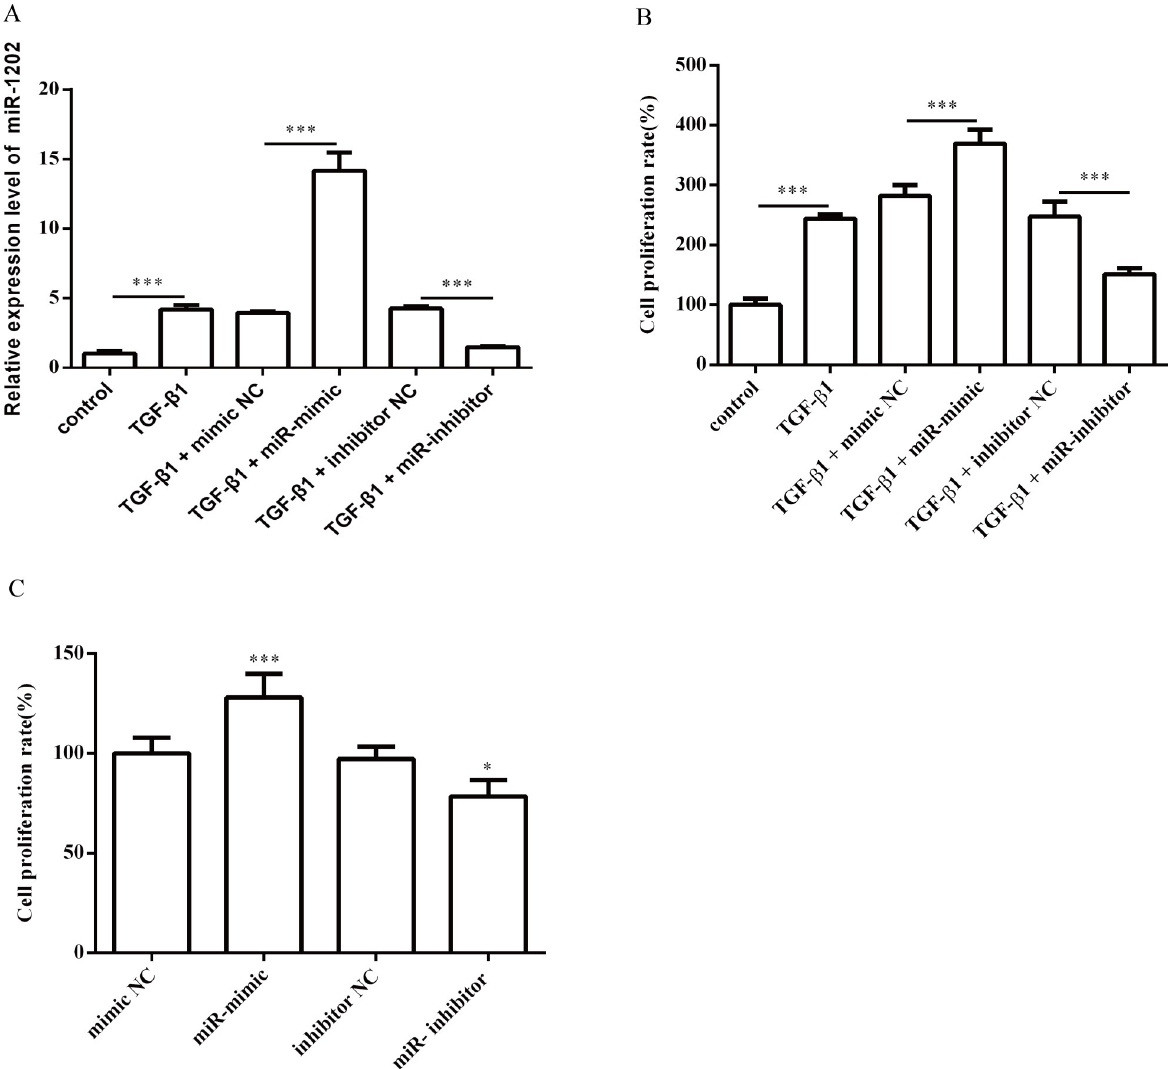
Fig 2. Effects of miR-1202 on the proliferation of HCFs treated with or without TGF- β 1. (A) The miR-1202 levels in TGF- β 1-induced HCFs cells; (B) The cell viability in TGF- β 1-induced HCFs; (C) The cell viability in HCFs without TGF- β 1 treatment. All of the data are expressed as the mean ± SD. Compared with the control group, n = 3, � P < 0.05; �� P < 0.01, ��� P < 0.001. The analysis is not able to detect small significant differences due to small sample